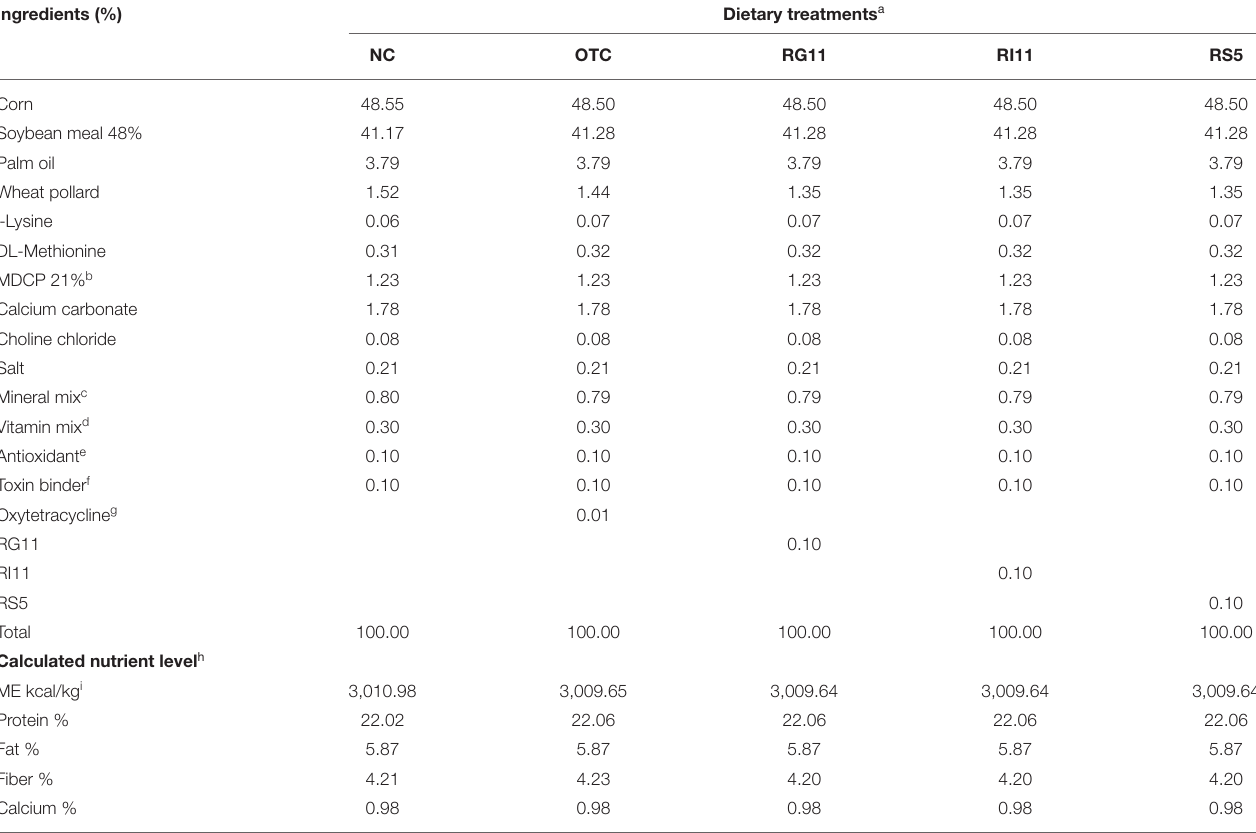
TABLE 1 | Ingredient composition and nutrient contents of the starter diet. Ingredients (%) Dietary treatments a NC OTC Corn Soybean meal 48%